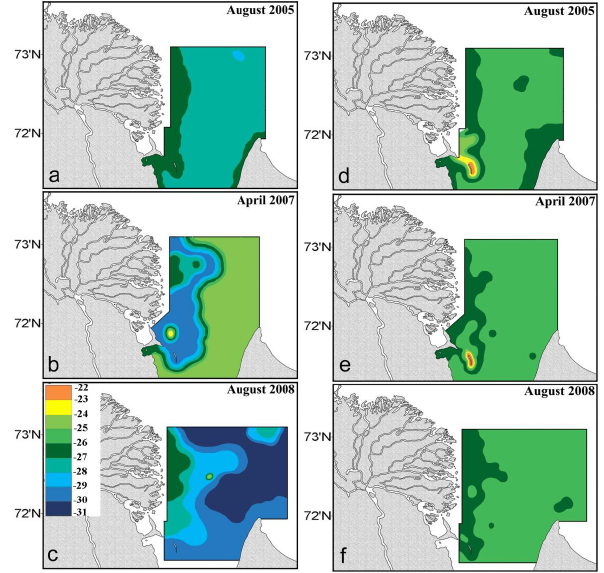
Fig. 7. Inter-annual variability of particular organic carbon δ 13C observed in the Buor-Khaya Bay sea water (a, b, c) and surface sediments (d, e, f) . Observed value ranges (‰) are shown as colored rectangles in (c)